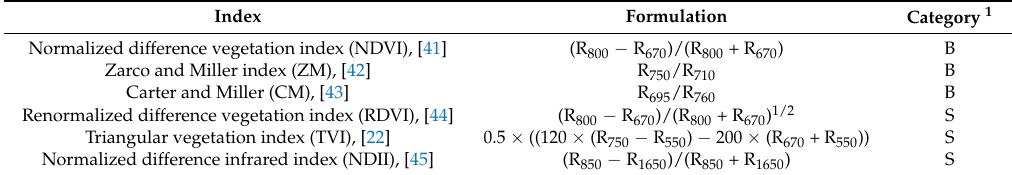
Table 1. Formulation of the two categories of biophysical (B) and structural (S) vegetation indices used in this study. R λ is the reflectance at the wavelength λ .